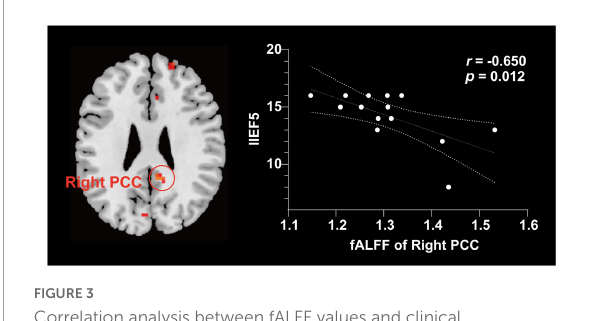
FIGURE3 Correlation analysis between fALFF values and clinical characteristics in patients with PED. The increase of IIEF5 score was negatively correlated with the increase of fALFF value in right. fALFF, fractional amplitude of low frequency fluctuation; PCC, posterior cingulate cortex; IIEF5, 5-item international index of erectile